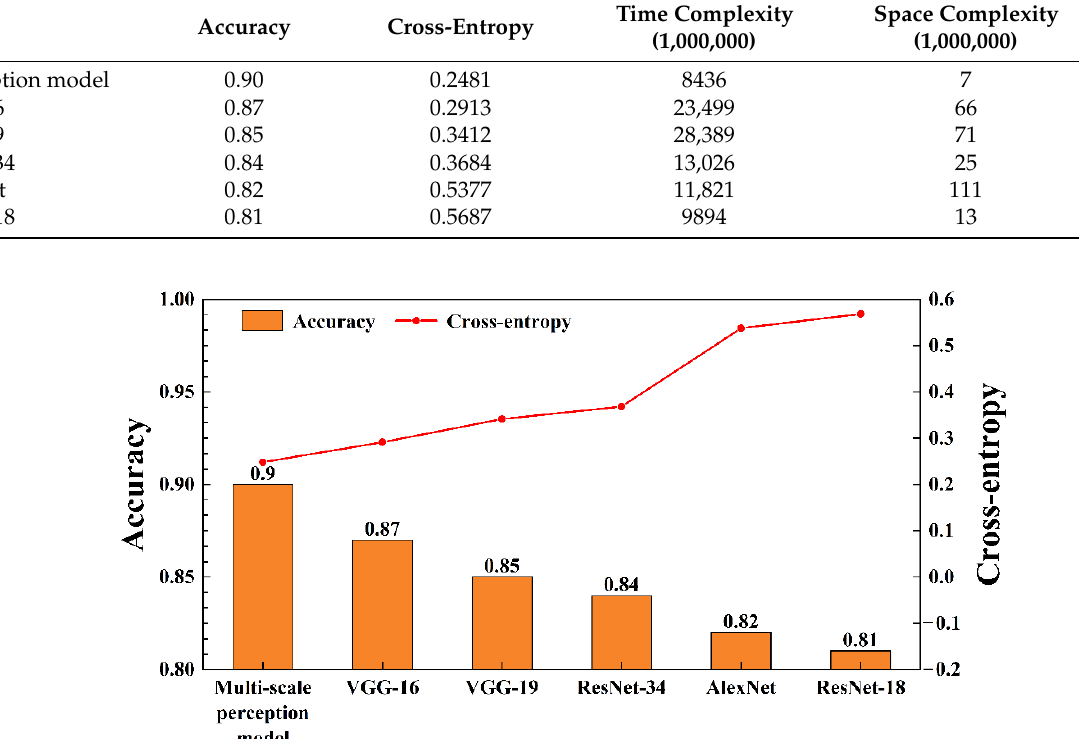
Figure 11. Comparison of accuracy of different models.